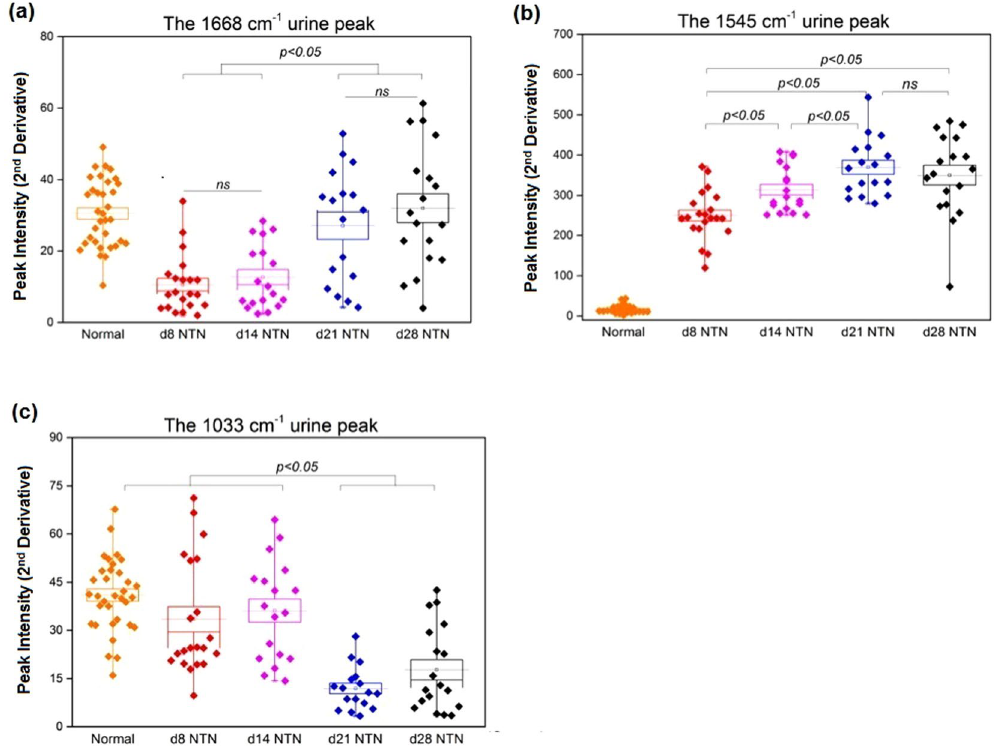
Figure 4. The 1668 cm − 1 , 1545 cm − 1 and 1033 cm − 1 IR peaks behavior in relation to renal inflammation, the progression of renal injury and renal fibrosis. The intensity of the urinary 1668 cm − 1 spectral marker ( a ) was significant decreased in both d8NTN and d14 NTN groups (inflammation) compared with the normal group and the fibrotic group (i.e. d21NTN and d28NTN). The intensity of the urinary 1545 cm − 1 spectral marker ( b ) increased as nephritis progressed. The 1033 cm − 1 spectral marker ( c ) showed a marked reduction in the fibrotic group compared to the normal and inflammatory groups. (Boxes are mean ± SD. Data was analyzed by one-way ANOVA and subsequent Fisher’s LSD post hoc test for mean comparisons).